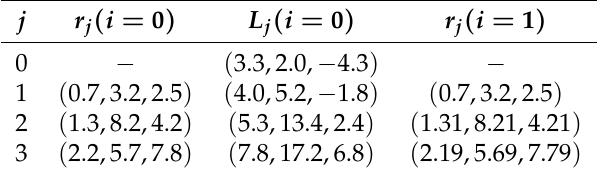
Table A3. Intermolecular distances and bounds for the numerical example at iterations i = 0 and i = 1.